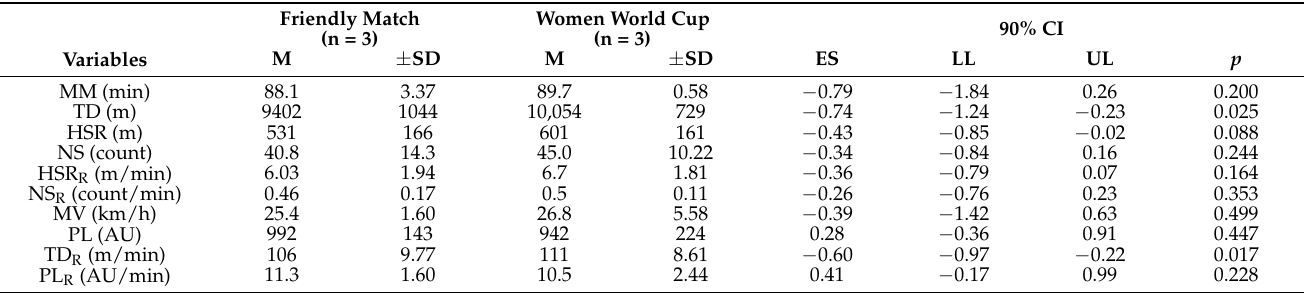
Table 1. Description and differences of external load between